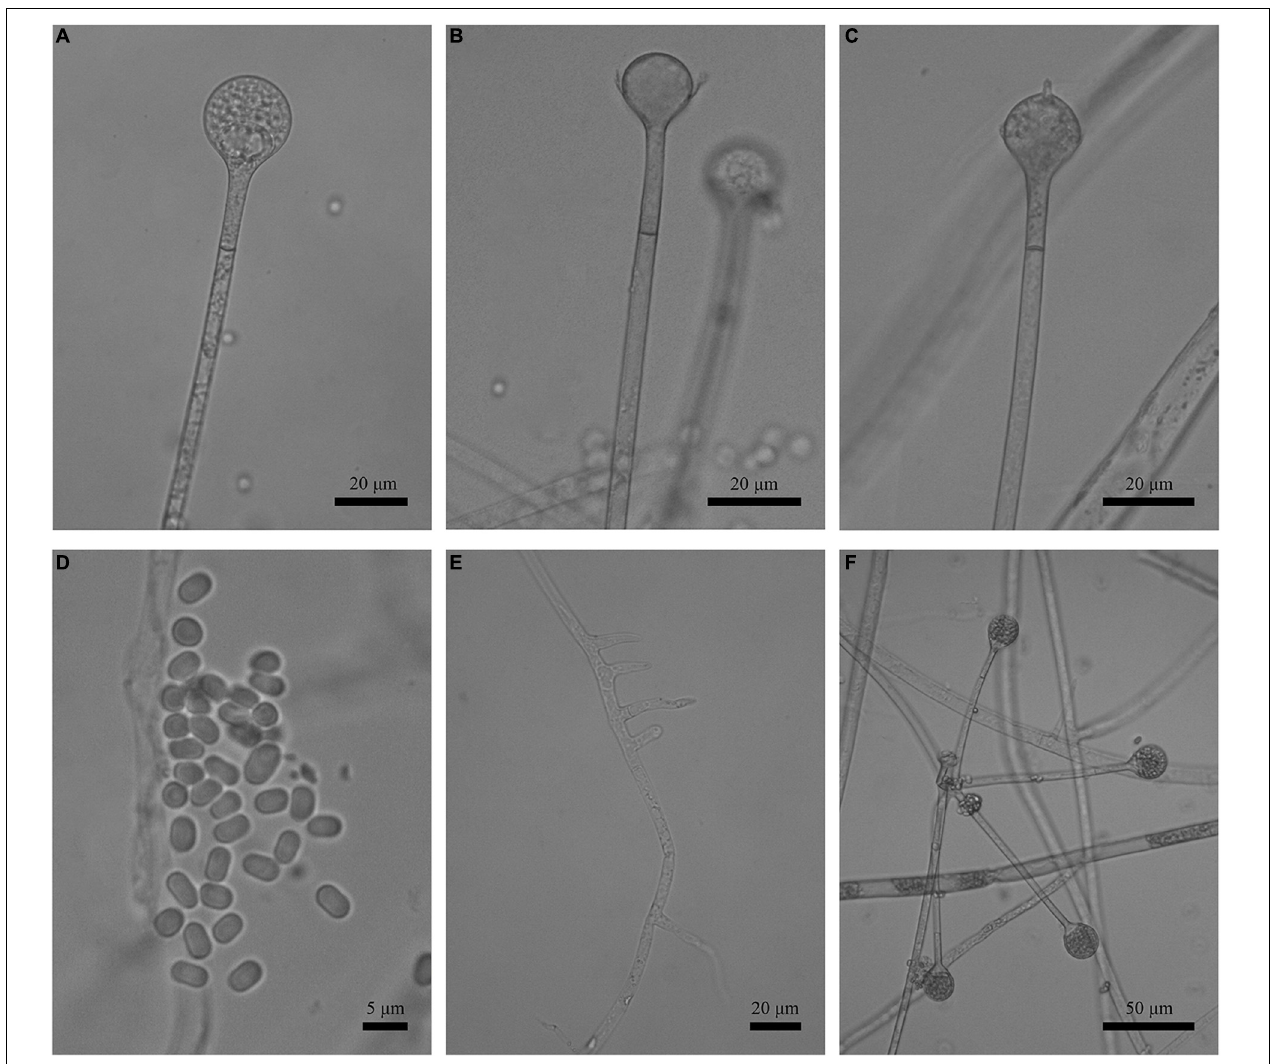
FIGURE 10 | Morphologies of Absidia zonata CGMCC 3.16033. (A) Sporangium; (B,C) columellae; (D) sporangiospores; (E) rhizoids; (F) verticillately branched sporangiophores. Scale bars: (A–C,E) 20 µ m; (D) 5 µ m; (F) 50 µ